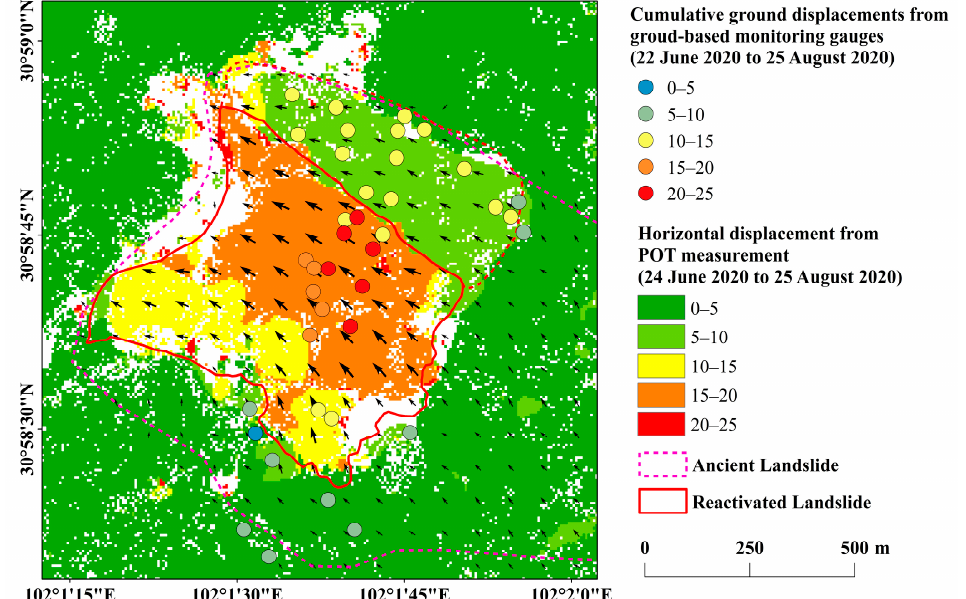
Figure 8. Validation between ground-based monitoring result and the POT result. Note that the ground-based monitoring result is collected from the published paper [7]. Black arrows represent the directions of horizontal